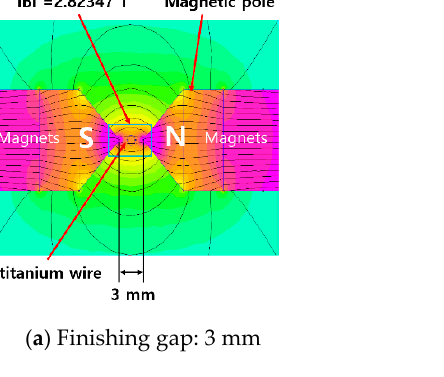
Figure 6. Front view of sharp-edged magnetic field analyzed by FEMM. Appl. Sci. 2020 , 10 , x FOR PEER REVIEW